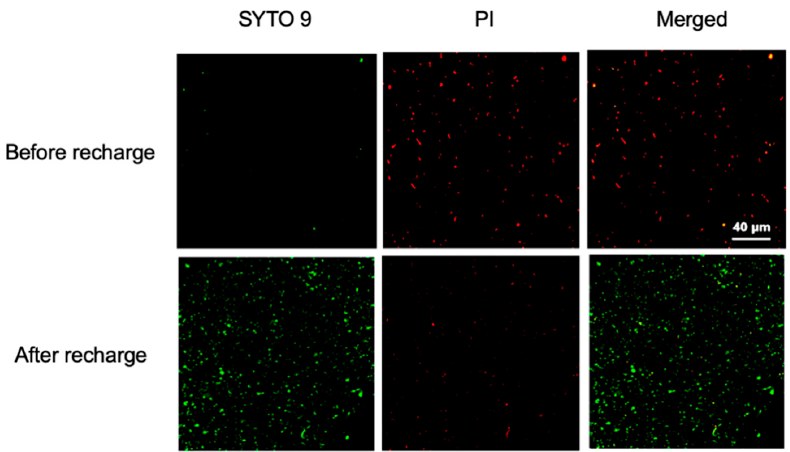
Figure 5. Recycle and recharge engineered living materials (ELMs) after the photocatalytic degradation process: ( a ) Recycling and reuse cycle of ELMs. After degrading trypan blue for 24 h, the ELMs were collected and used to degrade fresh trypan blue solution. The photocatalytic degradation efficiency was lower than that of freshly prepared ELMs. The recycled ELMs were incubated in Luria Bertani (LB) medium solution. After a 24-h incubation, the recharged ELMs were used for the photocatalytic degradation of trypan blue; the observed efficiency was comparable to that of freshly prepared ELMs; ( b ) Degradation efficiency of freshly prepared ELMs, used ELMs, and recharged ELMs after 24 h of treatment. The photocatalytic degradation efficiency of ELMs decreased after incubation with trypan blue but recovered after incubation with LB medium solution. The data are presented as mean ± s.d ( n = 2).